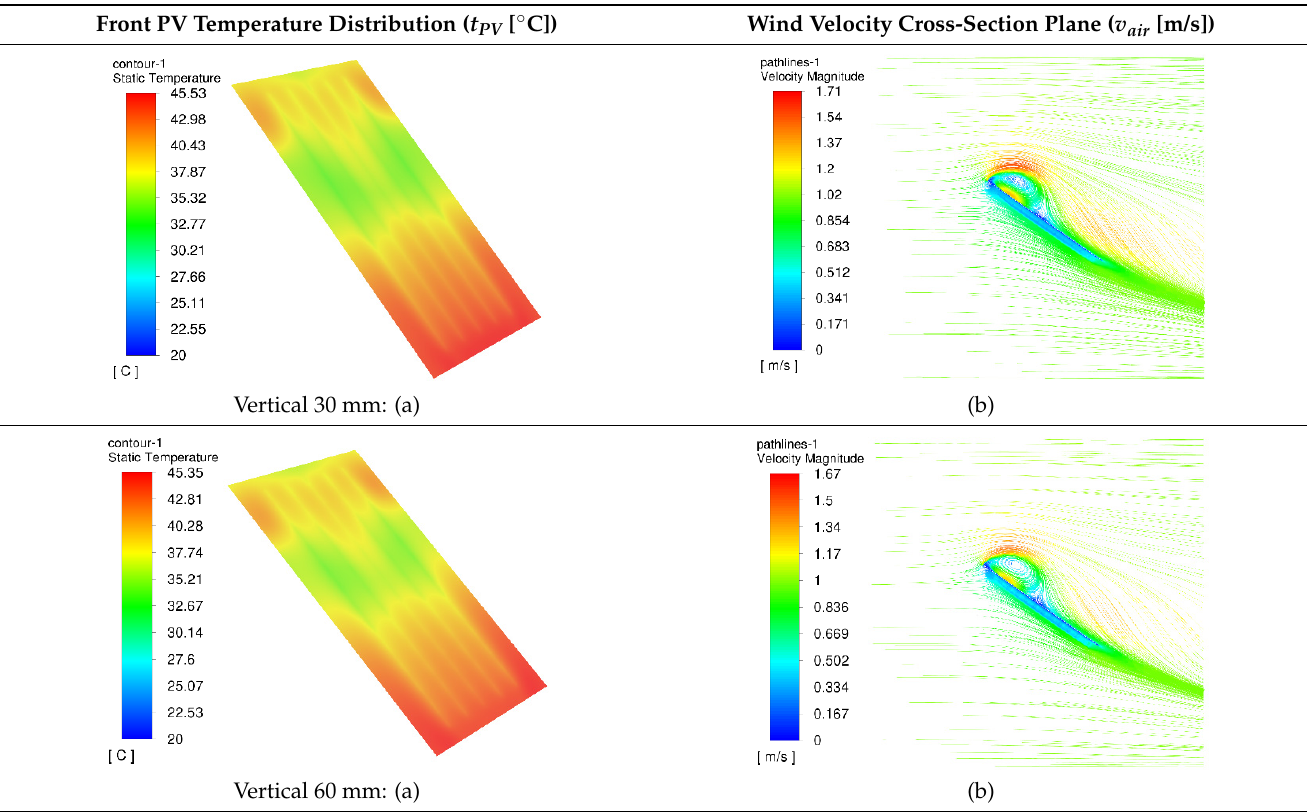
Figure 9. Variation of average operating temperature and convective heat transfer coefficient for studied cases ( G = 800 W/m 2 , v air = 1 m/s and t air = 20–35 °C). Figure 10. Variation of average operating temperature and convective heat transfer coefficient for studied cases ( G = 600 W/m 2 , v air = 1 m/s and t air = 20–35 °C). An interesting aspect was recorded on convective heat transfer coefficients. There- fore, for horizontal heat sinks the h c on the front of the PV panel were much closer to the h c on the back, compared to vertical ones, where an important difference was recorded. The ambient temperature variation did not seem to change the best configuration (Case 2—horizontal 30 mm). This configuration determined a drop of temperature as presented in Table 6.